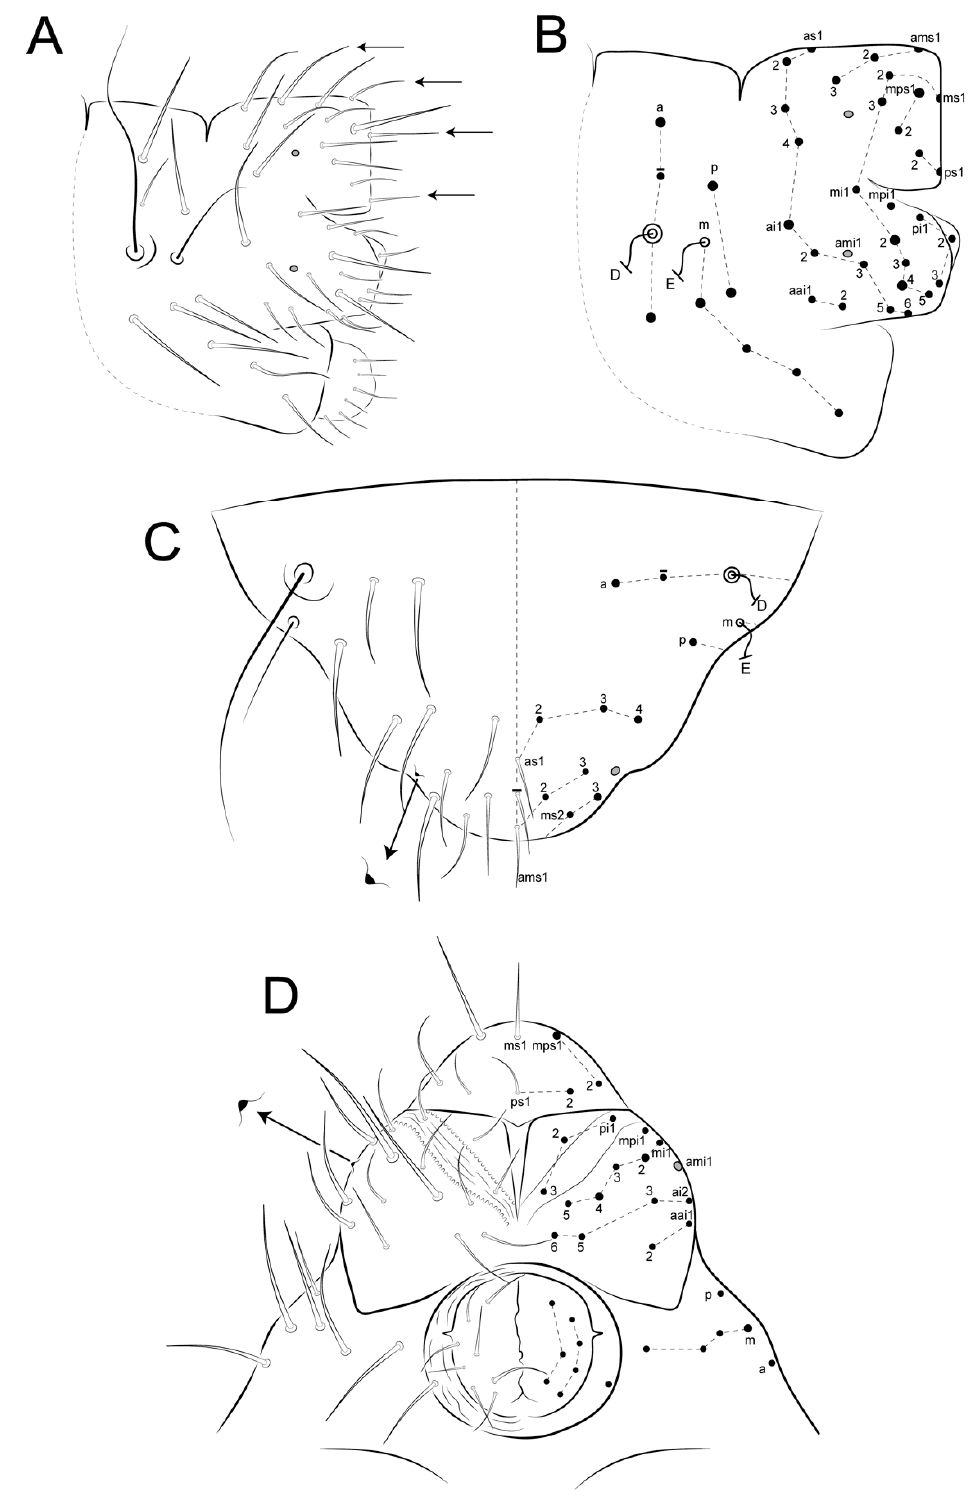
Figure 12. Arlesminthurus caatinguensis sp. nov. male small abdomen: ( A,B ) lateral view, ( A ) as observed, arrows indicate unpaired chaetae ( as1, ams1, ms1 and ps1 ), ( B ) schematic representation; ( C ) dorsal view; ( D ) ventral view of the small abdomen and the genital plate; arrows in both C and D figures show the oval organs, the left side shown as observed and on the right side a schematic representation is displayed.